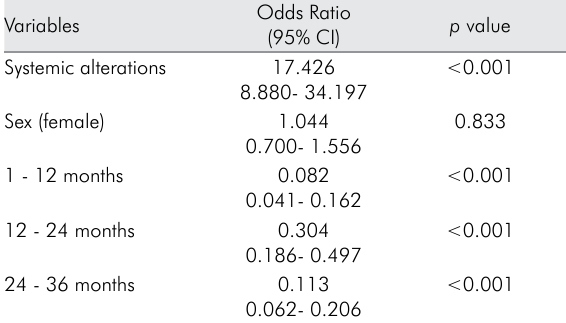
Table 5. Results of the logistic regression using oral manifes- tations as the dependent variable and the other variables as independent